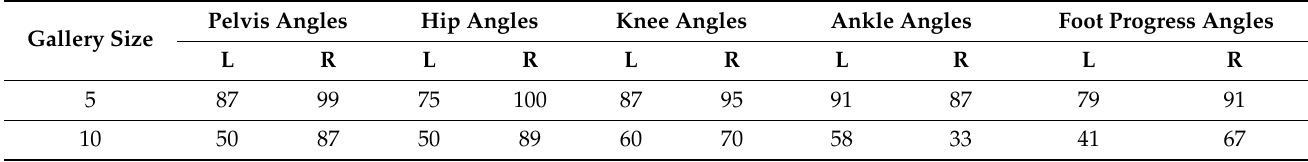
Table 1. Gait classifier recognition rates using individual variables and combinations of all spatiotemporal variables. Pelvis Angles Hip Angles Knee Angles Ankle Angles Foot Progress Gallery Size